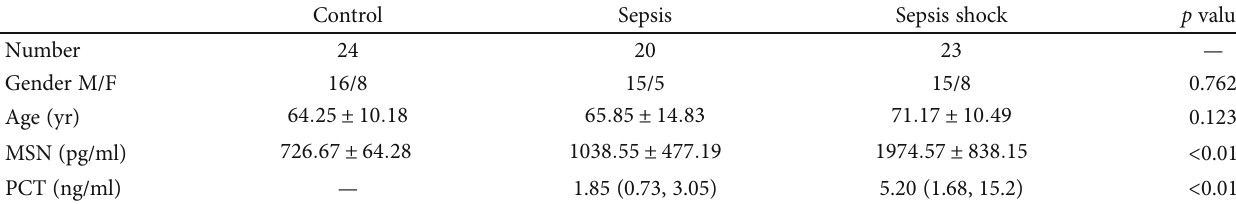
Table 1: The demographic and clinical characteristics of